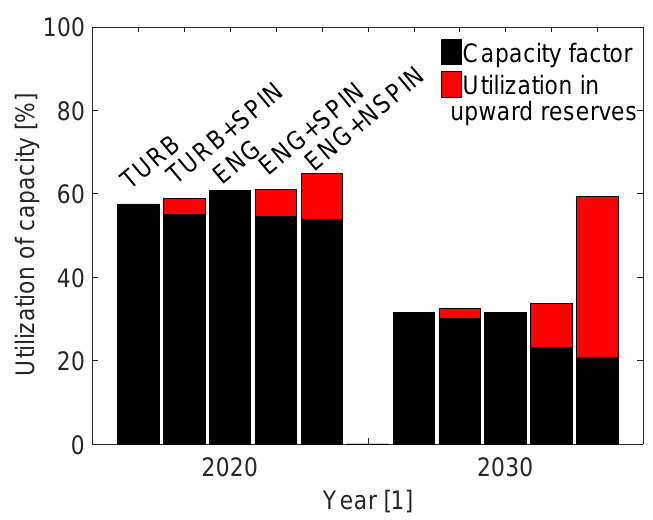
Figure 4. Utilization of installed capacity in energy and reserve production for the gas-fired technologies in 2020 and 2030. The bars are in the same order in the case of 2020 and 2030.